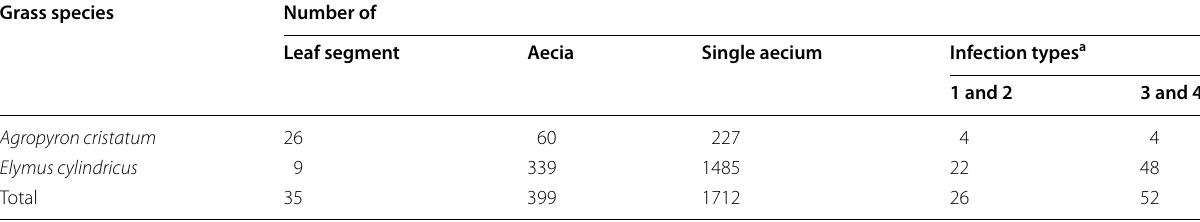
Table 3 Infection types (ITs) of Puccinia striiformis f. sp. tritici isolates recovered from aeciospores on barberry ( Berberis shensiana ) seedlings Grass